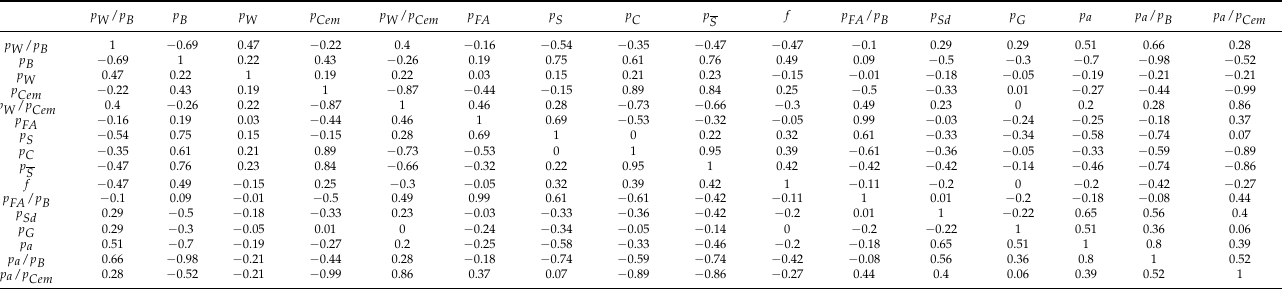
Table 2. Spearman’s correlation coefficient of top